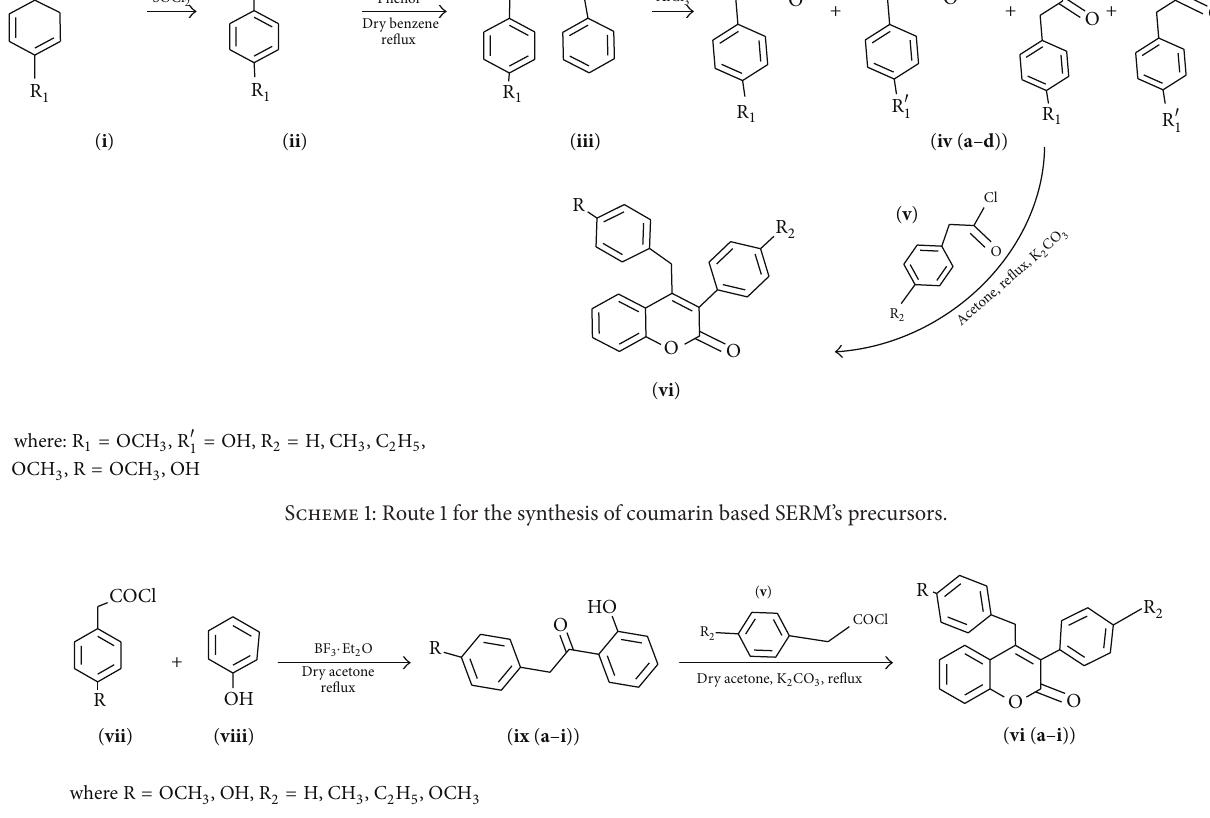
Scheme 2: Route 2 for the synthesis of coumarin based SERM’s